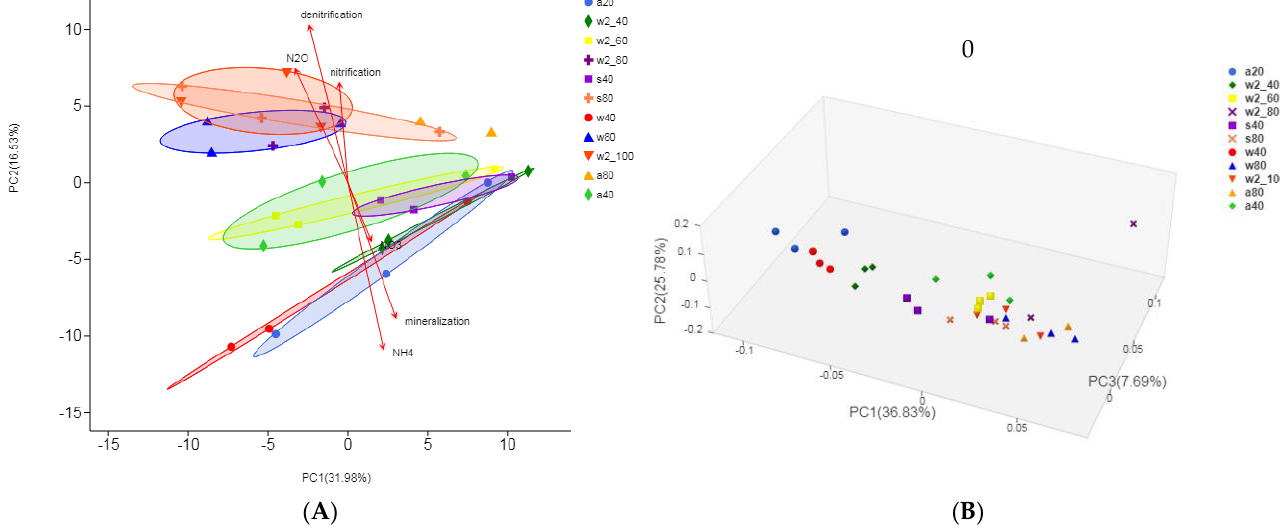
Figure 6. ( A ) Order level PCA plot showing patterns of beta diversity in 11 soil samples of various immediate and early moisture. Bacterial communities are ordinated against six variables. ( B ) Order level 3D-PCoA is based on the weighted Unifrac distance and shows the separation of different bacterial communities under five moisture regimes. a20, 20% WHC for one week; a80, 80% WHC for two weeks; a40, 40% WHC for two weeks; w40, 40% WHC for two weeks; w80, 80% WHC for two weeks; s40, 40% WHC for four weeks; s80, 80% WHC for four weeks; w2_40, 40% WHC for one week; w2_60, 60% WHC for one week; w2_80, 80% WHC for one week; w2_100, 100% WHC for one